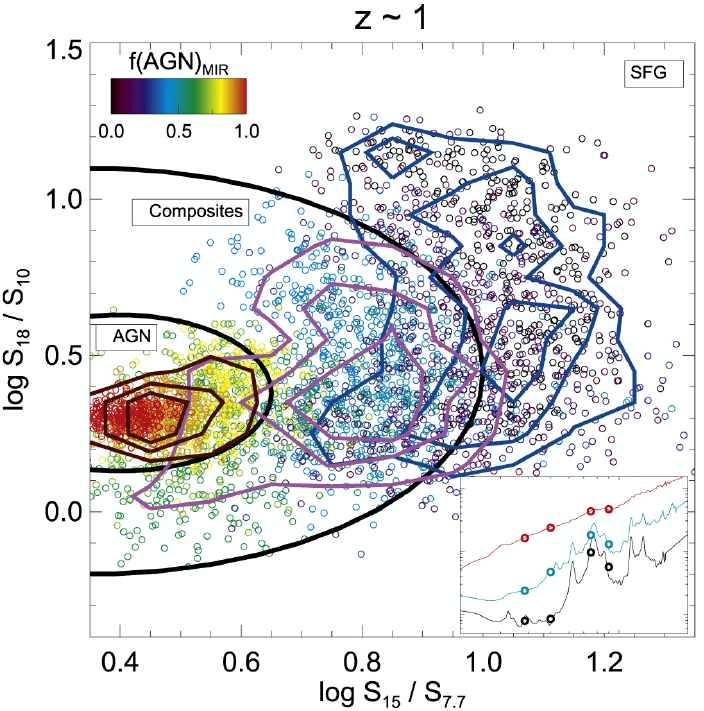
Figure 20. AGN fraction determination based on JWST MIRI colors for z scheme represents the fraction of mid-IR emission that is AGN powered [94]. The inset shows typical mid-IR spectra for an AGN, a composite or a star-forming galaxy (from top-to-bottom). Reproduced with permission from Kirkpatrick et al. [94], AAS ©